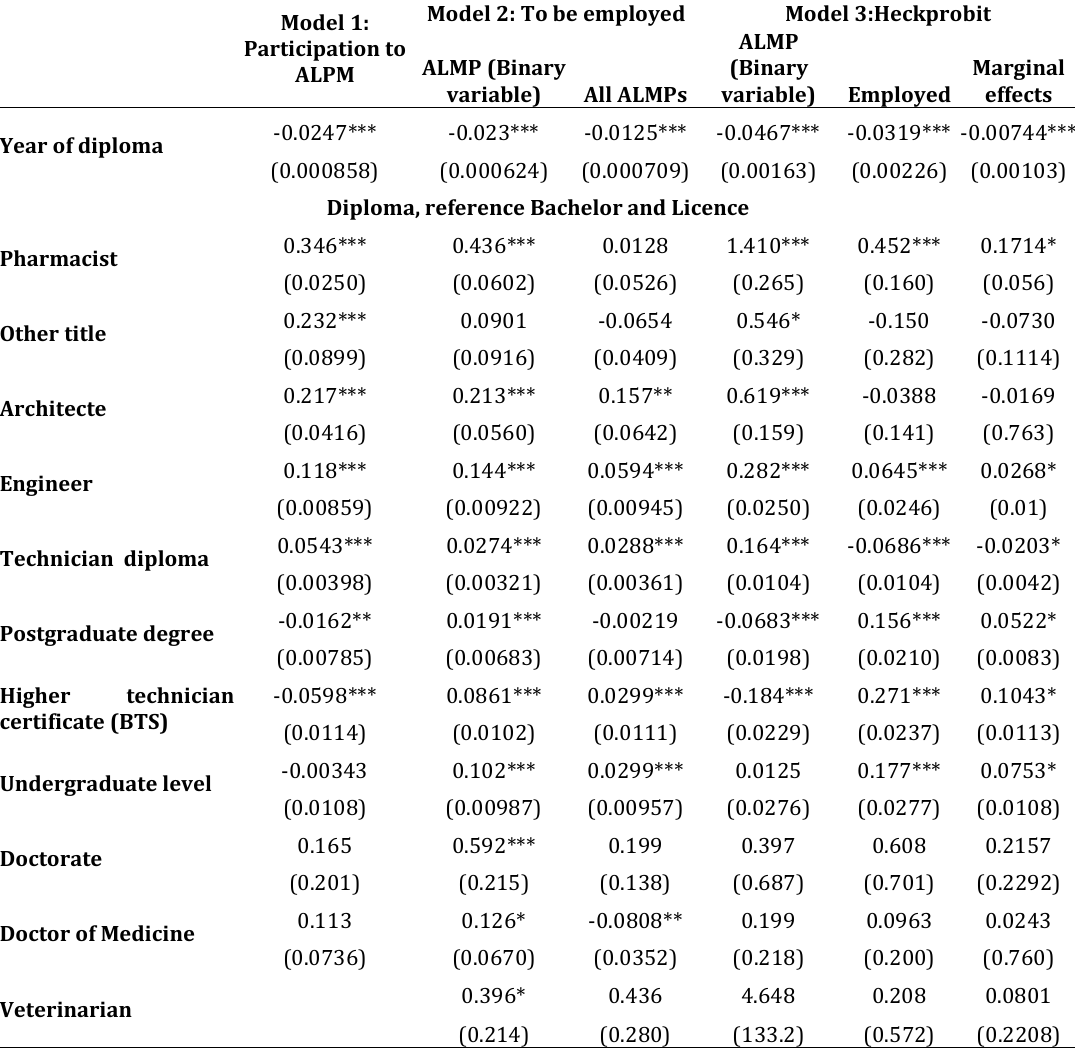
Table 4: Impact of training characteristics on ALMPs participation and professional